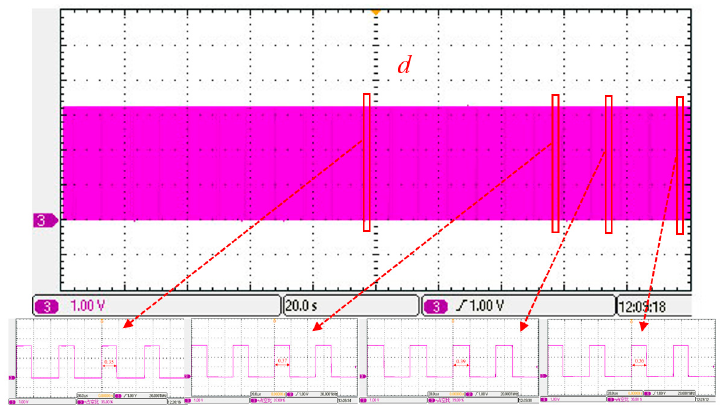
Figure 23. The duty cycle variation from TMS320F28335 under the WLTP.